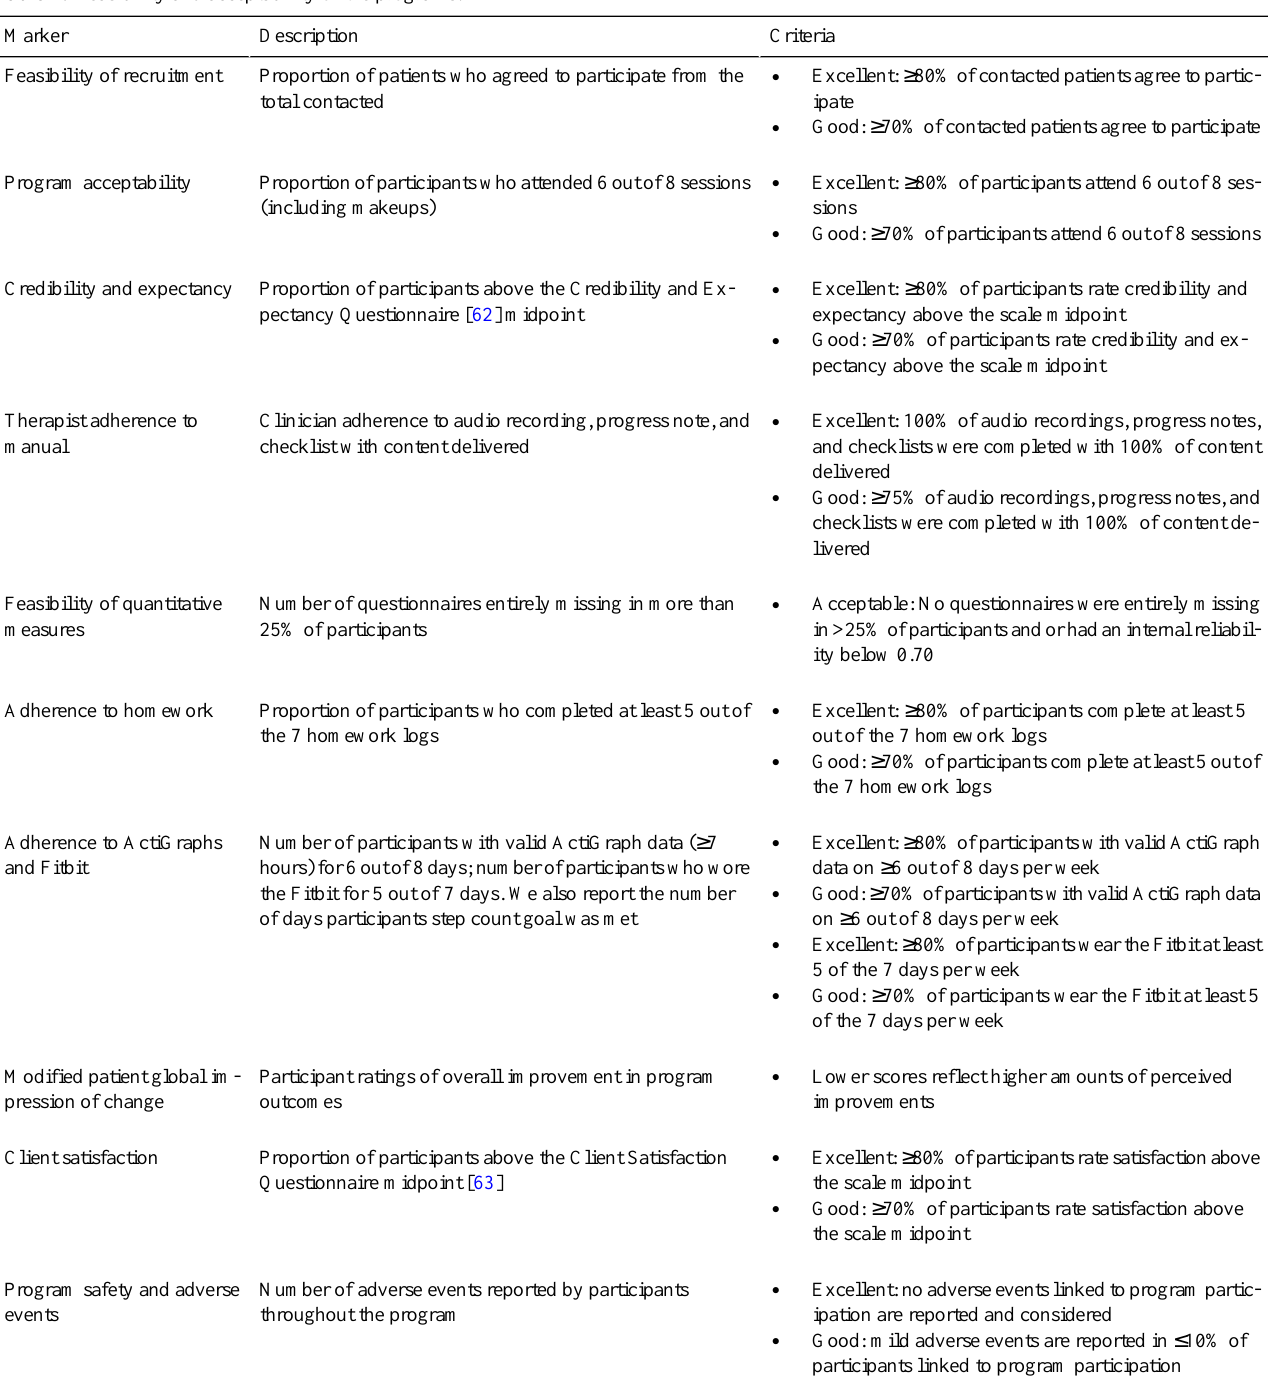
Table 2. Feasibility and acceptability of the programs. a